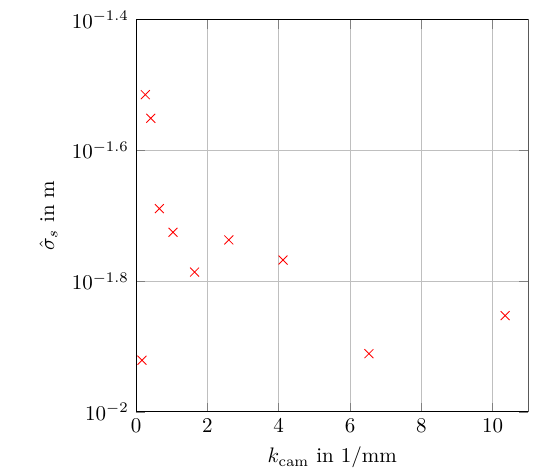
Figure 25. Measurement uncertainty of the plenoptic sensor for different main lens focal lengths f and a perfect diffusely reflecting surface.